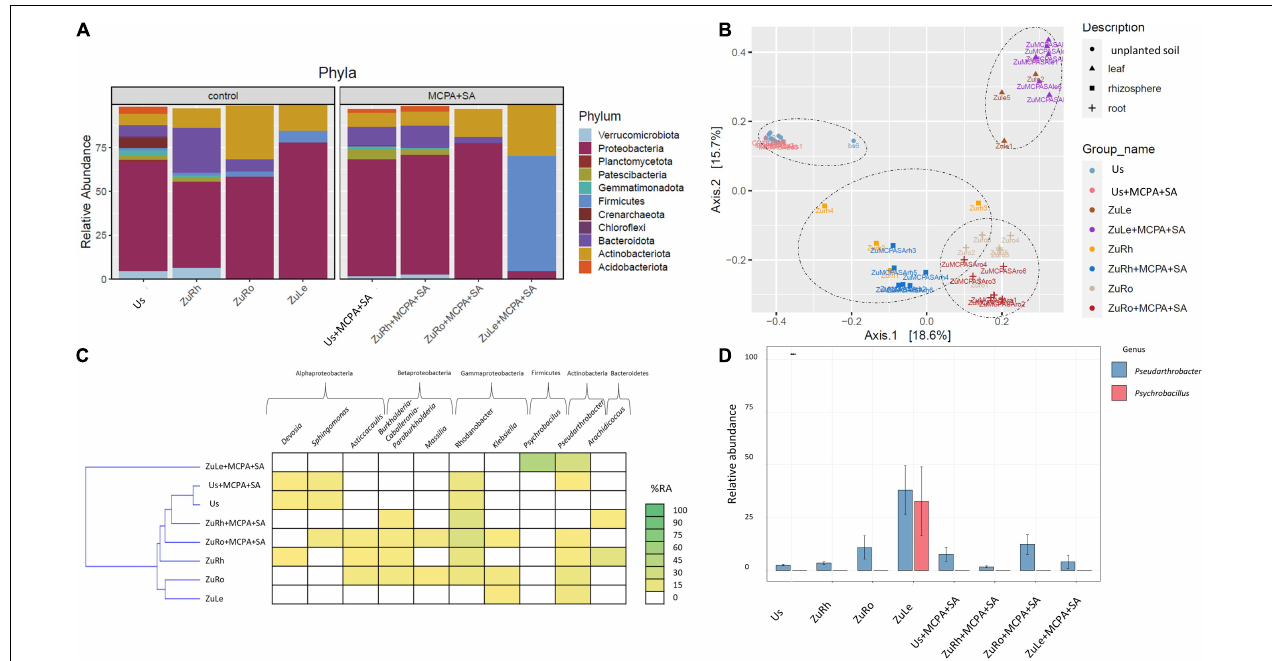
FIGURE 4 | Bacterial community structure based on 16S rRNA gene sequence for MCPA + SA-amended variants in comparison to untreated variants: (A) Relative abundances (%) of the bacterial community at the phylum level; (B) PcoA ordination plots of the results based on the Bray–Curtis distances of the classified 16S rRNA gene sequences; (C) Heat map of top 10 genera in each treatment; (D) Relative abundance (%) of Pseudarthrobacter and Psychrobacillus in the different treatments. Variants: Us, unplanted soil; ZuRh, zucchini rhizosphere soil; ZuRo, zucchini root; ZuLe, zucchini leaves; Us + MCPA + SA, unplanted soil treated with MCPA and SA; ZuRh + MCPA + SA, zucchini rhizosphere soil treated with MCPA and SA; ZuRo + MCPA + SA, zucchini root from soil treated with MCPA and SA; ZuLe + MCPA + SA, zucchini leaves from soil treated with MCPA and SA.